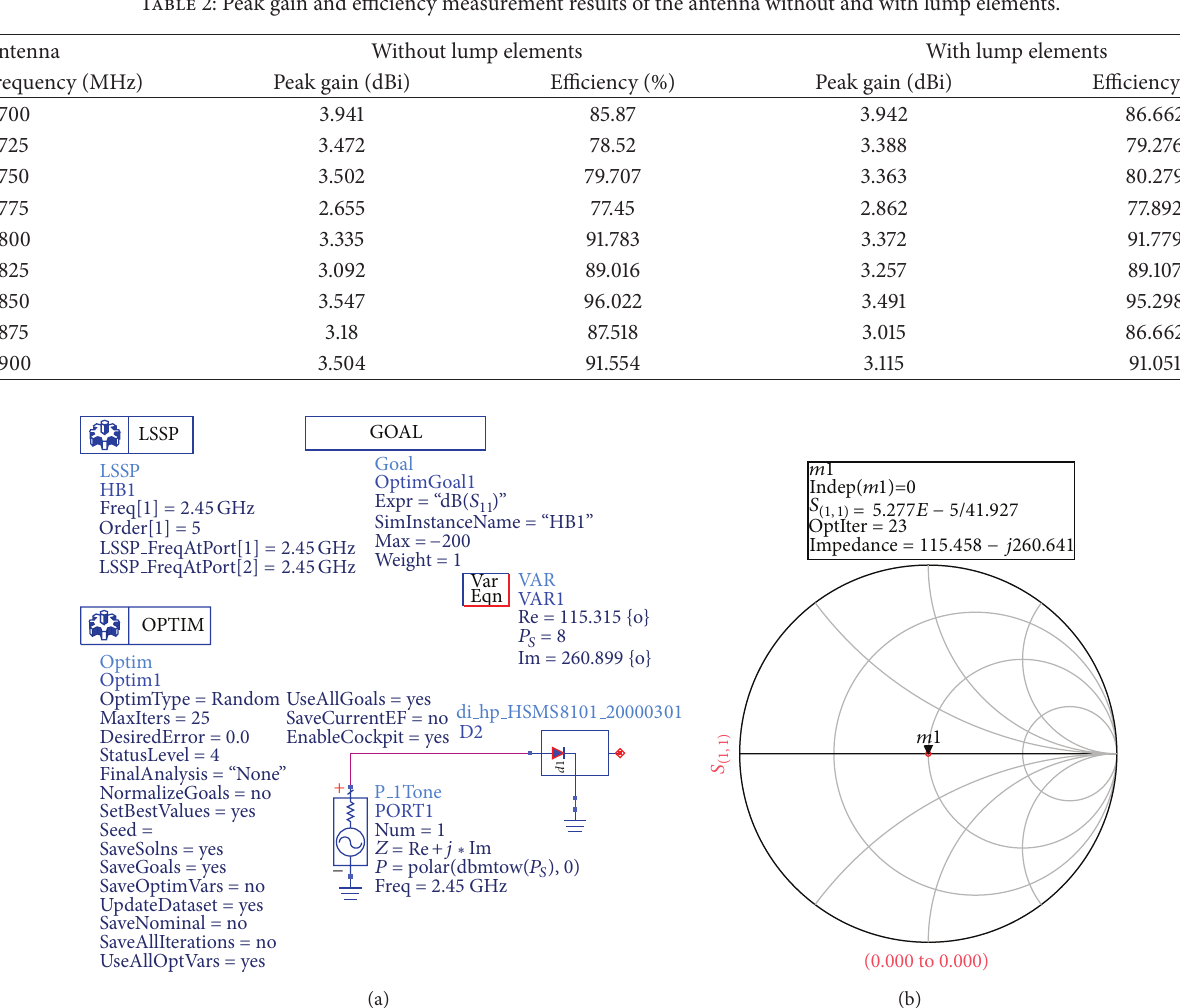
Figure 8: (a) Setup for calculation of the conjugate matching impedance of the diode and (b) the calculated conjugate matching impedance of the diode in Smith